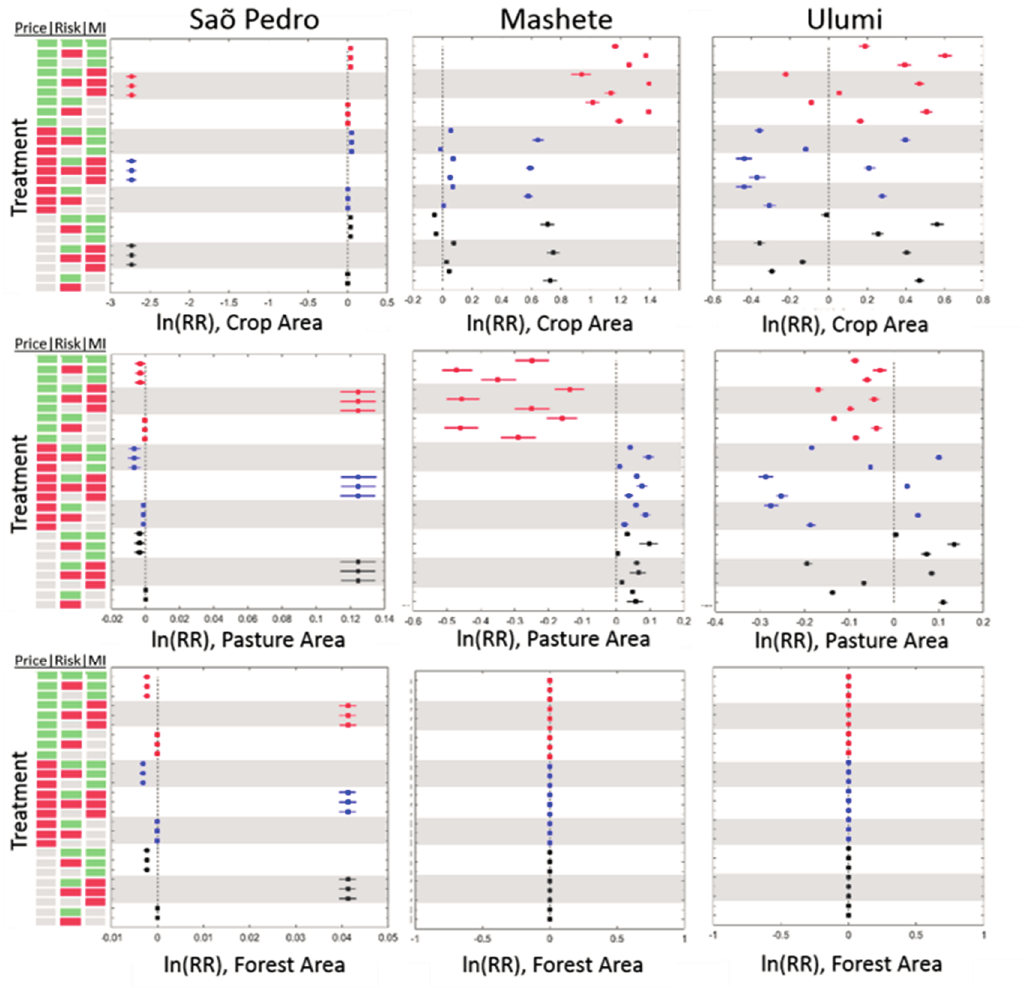
Figure 6. Mean effect sizes of experimental treatments on landscape-level land use and land cover patterns. Experimental treatments are indicated in the color-coded panels on the far left and are displayed as combinations of commodity price (left column), average risk preference (middle column), and market influence (MI, right column) perturbations. Green, gray, and red treatment cells indicate increased, baseline, and decreased treatment values, respectively. Effect sizes are plotted with the mean and 95% confidence interval. Interpretation . Effect sizes are significant at α =0.05 level when intervals do not include zero or do not overlap between categories [73,74]. Within each plot, effect sizes are grouped and colored by commodity price level (red points = higher prices; blue points = lower prices; black points = baseline prices). White and gray bands group experimental treatments by market influence settings. Thus, the relative influence of risk preferences is shown by the amount of horizontal dispersion of points within a white/gray